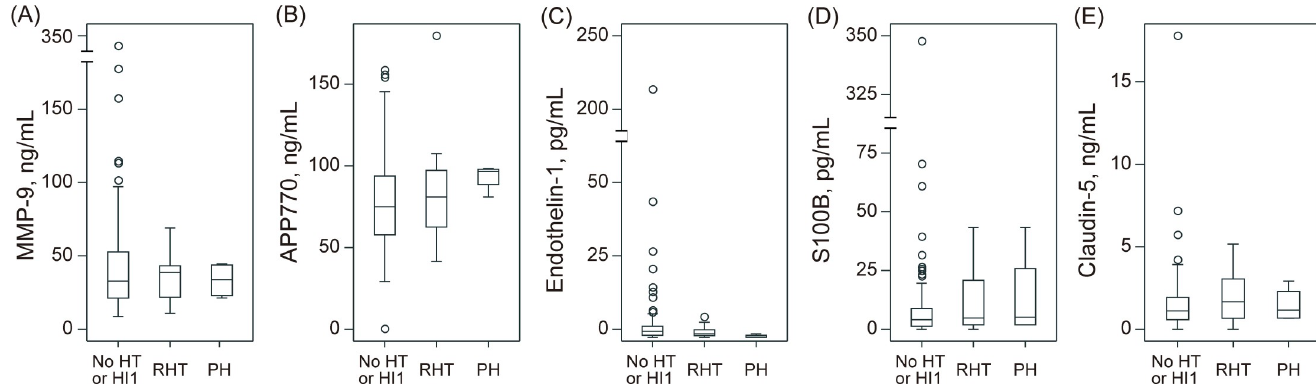
Fig 2. Association between hemorrhagic transformation and biomarkers. There was no significant association between hemorrhagic transformation type and serum biomarker levels. APP, amyloid precursor protein; HI, hemorrhagic infarction; HT, hemorrhagic transformation; MMP-9, matrix metalloproteinase-9; PH, parenchymal hematoma; RHT, relevant hemorrhagic transformation.